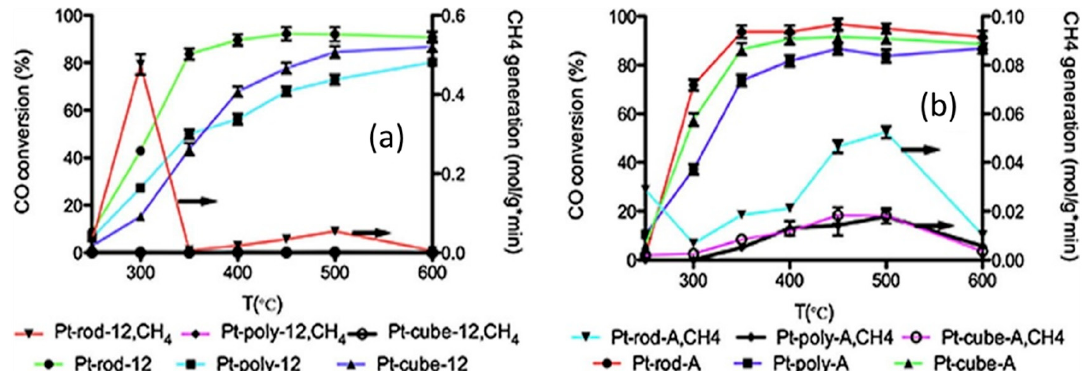
Figure 3. CO conversion of the catalysts prepared by ( a ) impregnation method and ( b ) (NH 4 ) 2 CO 3